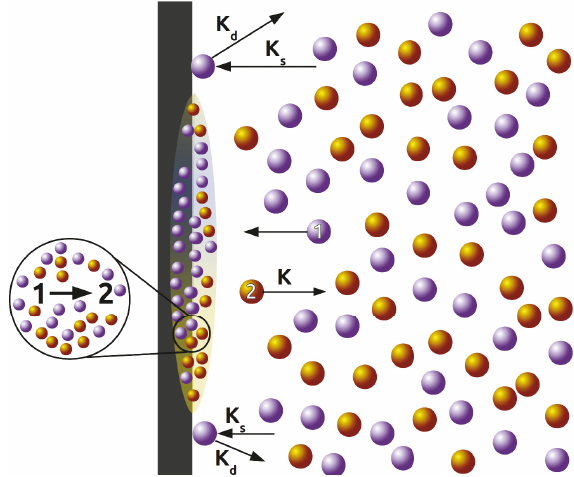
Figure 1: Illustration of theinteractions occurring between particles and, for example, a catalyst surface. Species 1 in contact with the surface can either be adsorbed or sorbed and by a reaction process produce species 2 , i.e., 1 󳨀→ 2